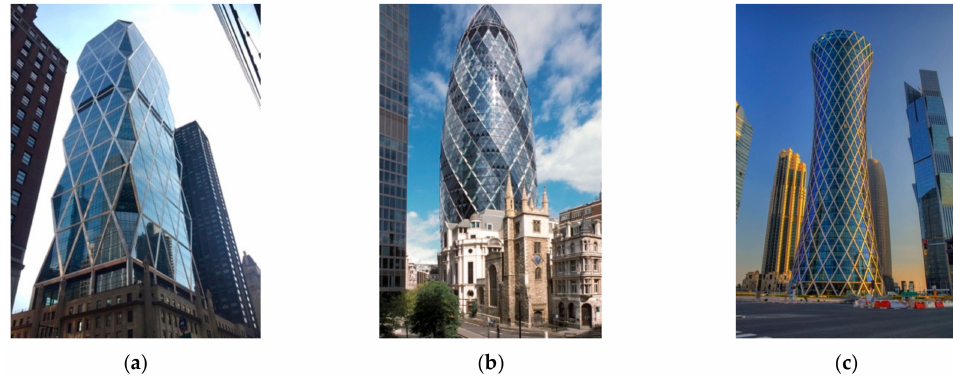
Figure 2. Examples of diagrid systems in tall buildings: ( a ) Hearst Tower (New York, USA), picture taken by D. Scaramozzino; ( b ) Swiss Re Tower (London, UK), from https: // larryspeck.com / ; ( c ) Tornado Tower (Doha, Qatar), from http: // www.asergeev.com /